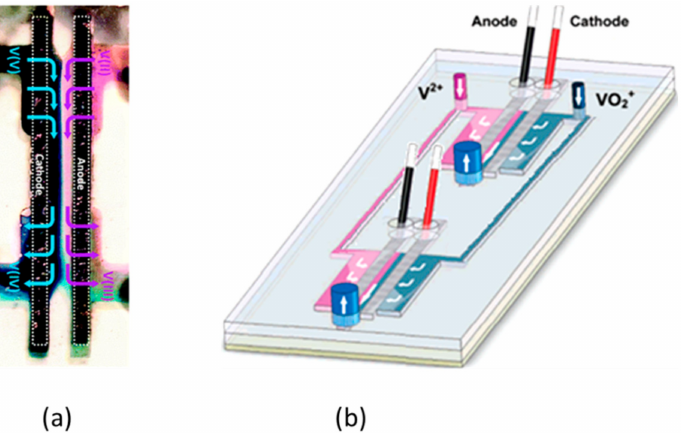
Figure 5. Duel-pass configurations: ( a ) dual-pass vanadium redox flow battery (reprinted from ref. [123]. Copyright 2013 RSC), and ( b ) dual-pass MMFC [132].